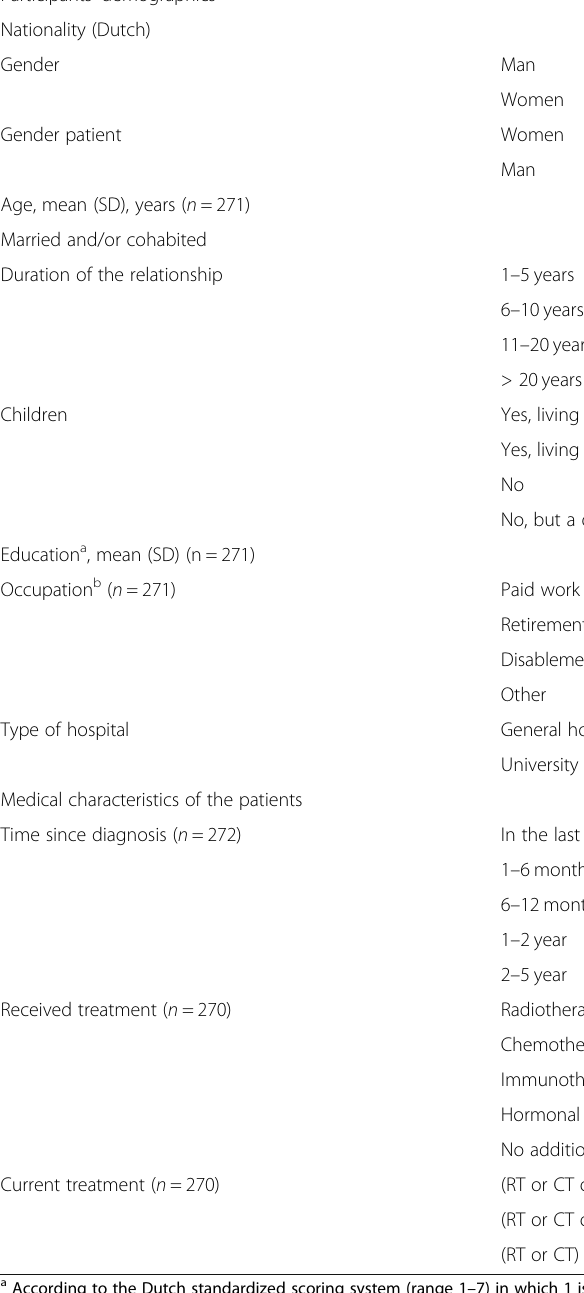
Table 1 Participants ’ demographics and patients medical characteristics ( n = 272) Participants ’